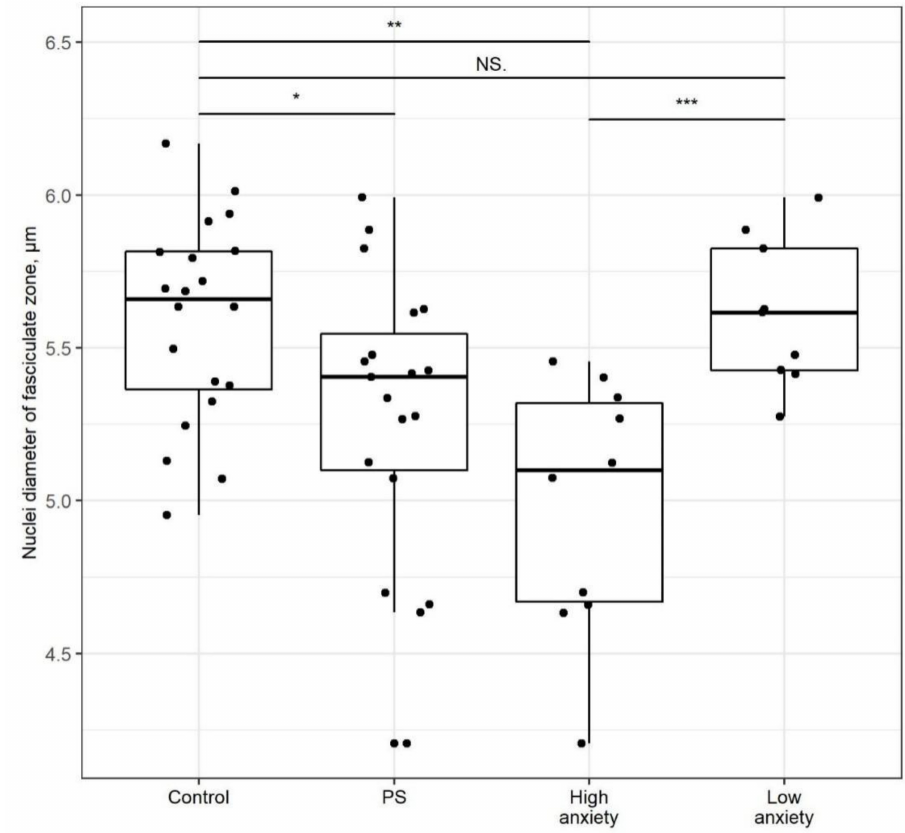
Figure 8. Nucleus diameter in the zona fasciculate is decreases after PSS . Nucleus diameter of cells in the zona fasciculata of control, PSS, high- and low-anxiety rats. Differences in adrenal cortex thickness values among groups are shown as boxplots with dots rep-resenting individual data values and medians shown by horizontal lines. The boxes include the central 50% of the data, i.e., from the 25th to the 75th percentile. The whiskers include the data contained within 1.5 times the interquartile range. NS = p > 0.05; * p < 0.05; ** p < 0.01; *** p < 0.001. p values determined in parametric